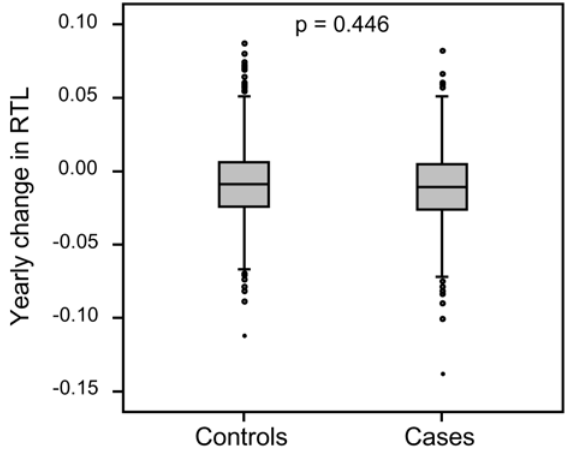
Figure 4. Individual telomere attrition rate was not a marker for future tumor development. Yearly telomere loss at the individual level did not differ between future tumor patients and